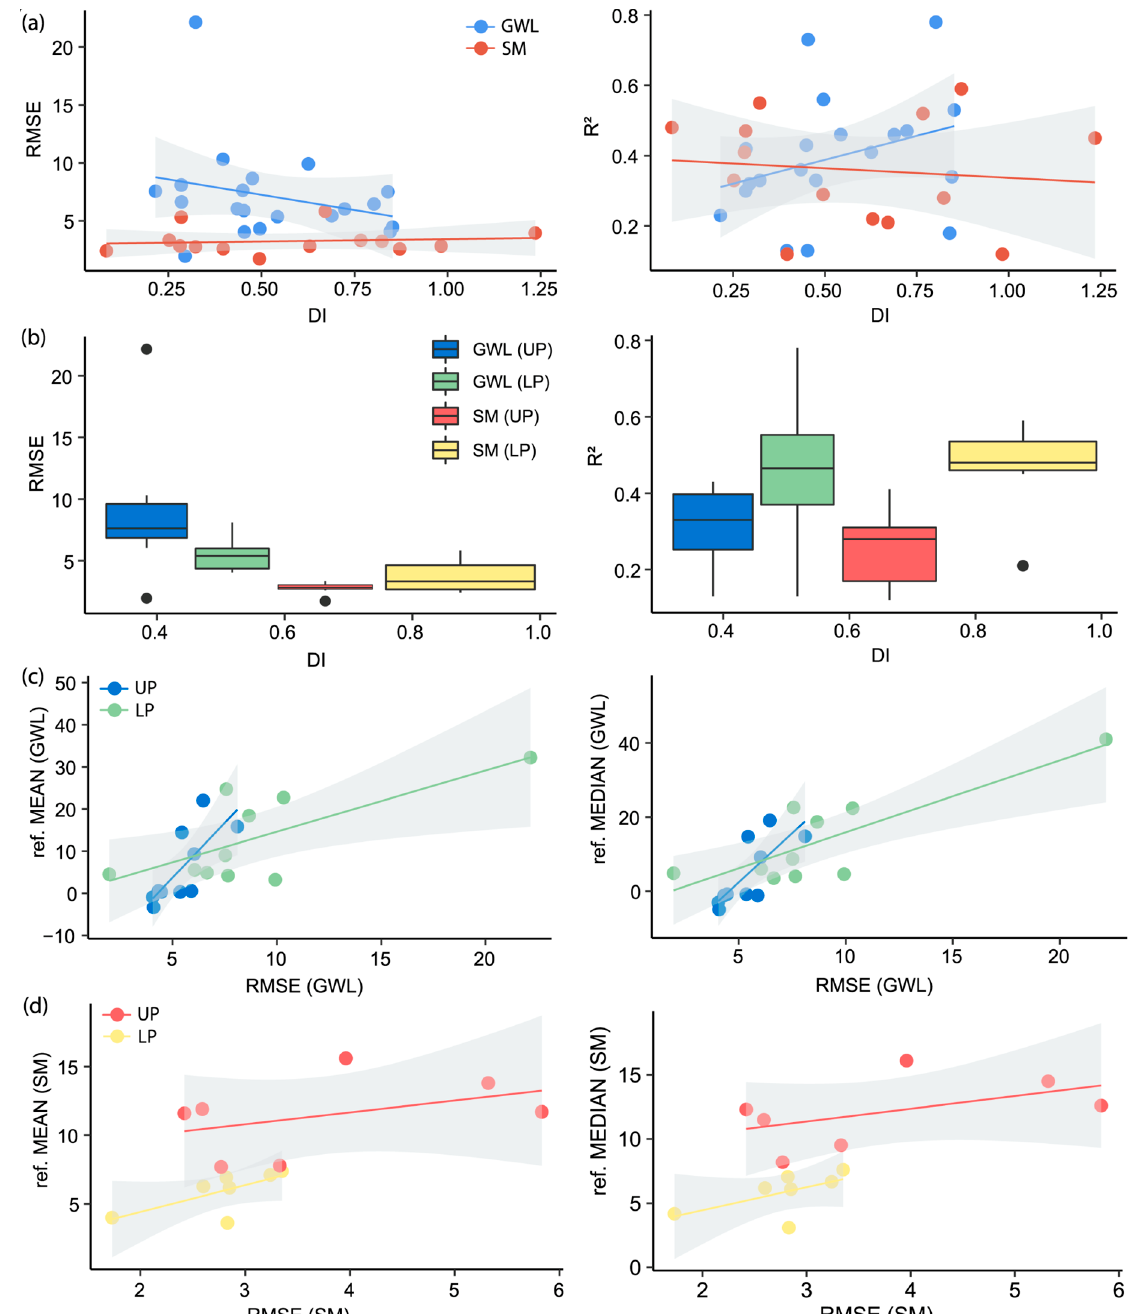
Figure 12. ( a ) Relationship between DIs and the absolute (RMSE) and the relative (R 2 ) model performances of GWL and SM of both sites. ( b ) Boxplots showing the DIs versus RMSE and R 2 variations of all models individually. ( c ) Relationship between the absolute performance of GWL RMSEs and the reference (ref.) GWL MEANs and the ref. GWL MEDIANs of the sampling data. ( d ) Showing trend between the absolute performances of SM RMSEs and the ref. SM MEANS and ref. SM MEDIANS of the sampling data.